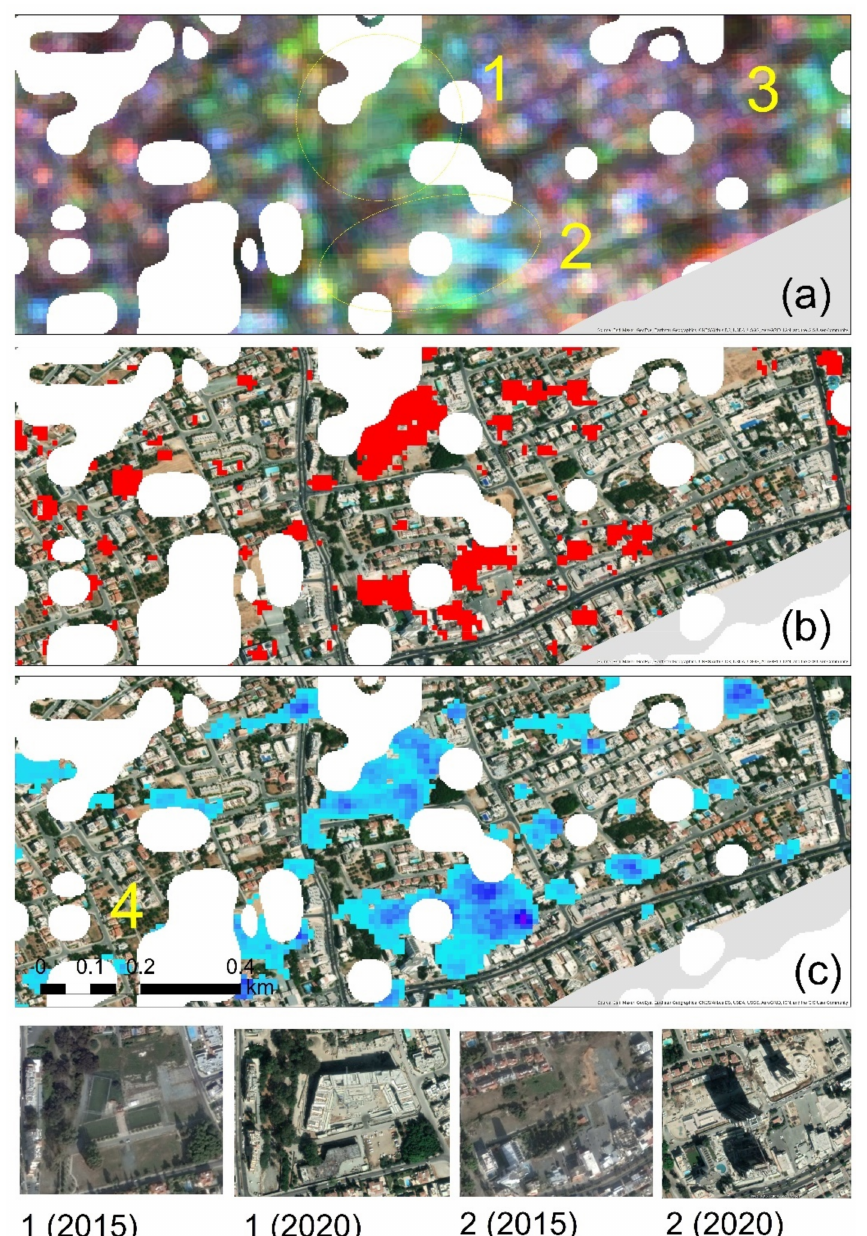
Figure 7. ( a ) VV and VH polarisations visualisation in Limassol city centre. The bright colour indicates changes within the observation period; ( b ) changes highlighted with red colour were recorded from the REACTIV algorithm for the same area as before; ( c ) cumulative changes using the statistical analysis. Specific areas mentioned in the text are shown with numbers 1–4. Non-urban areas, as classified from the optical Sentinel-2 image using the random forest classifier, are shown with white colour. On the bottom of the figure, screenshots of areas 1 and 2 were obtained from the Google Earth platform in 2015 and